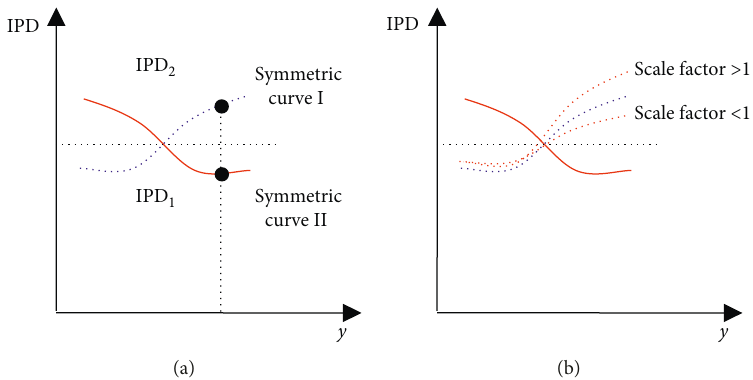
Figure 2: IPD correction for symmetry. (a) Without scale factor. (b) With scale factor for right side fixed scale factor, and the inner “min” operator yields the minimum value of the maximum BSE for all scale factors, and finally, the outer “min” operator gives the optimal BSE from the left- and right-side results. The output is the scale factor and the side (left or right) relevant to the minimum maximum BSE within ASAR.